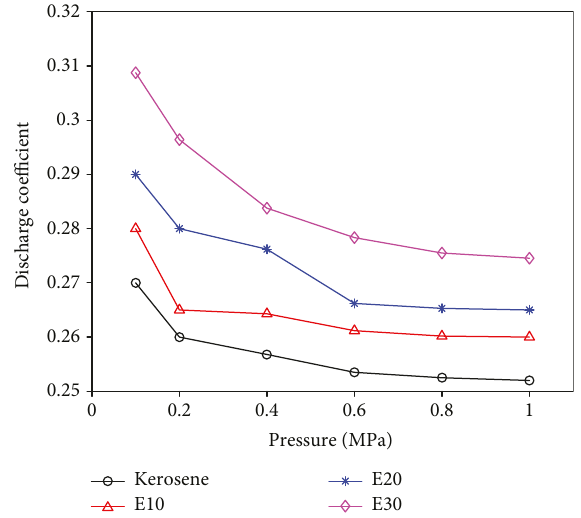
Figure 5: Scatter of measurement data points of spray cone angle with respect to (1).